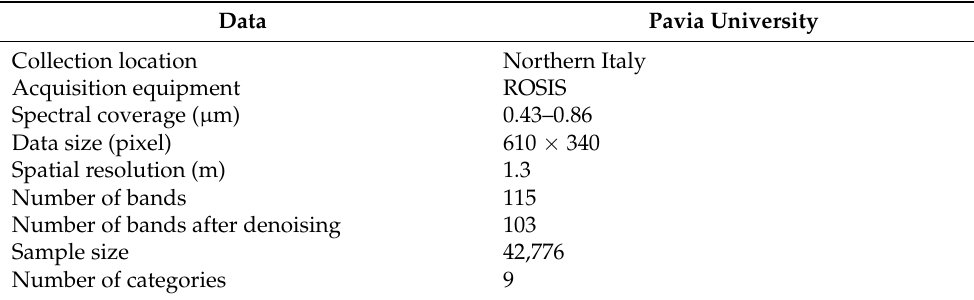
Table 1. Basic information of Pavia University data.